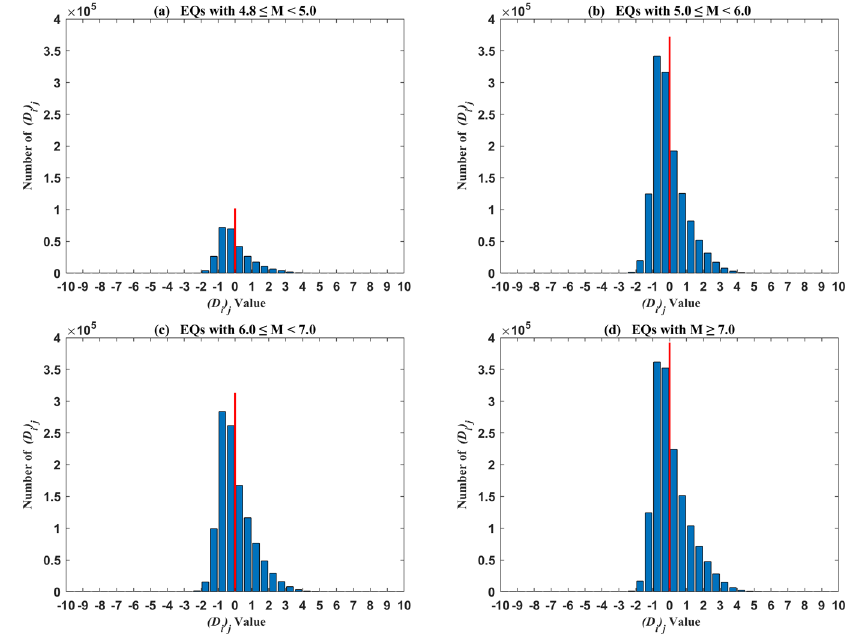
Figure 3. The histogram of ( D i ) j values obtained from earthquakes with different magnitudes, in- cluding EQs with M ≥ 4.8 and M < 5 ( a ), EQs with M ≥ 5 and M < 6 ( b ), EQs with M ≥ 6 and M < 7 ( c ) and EQs with M ≥ 7 ( d ).